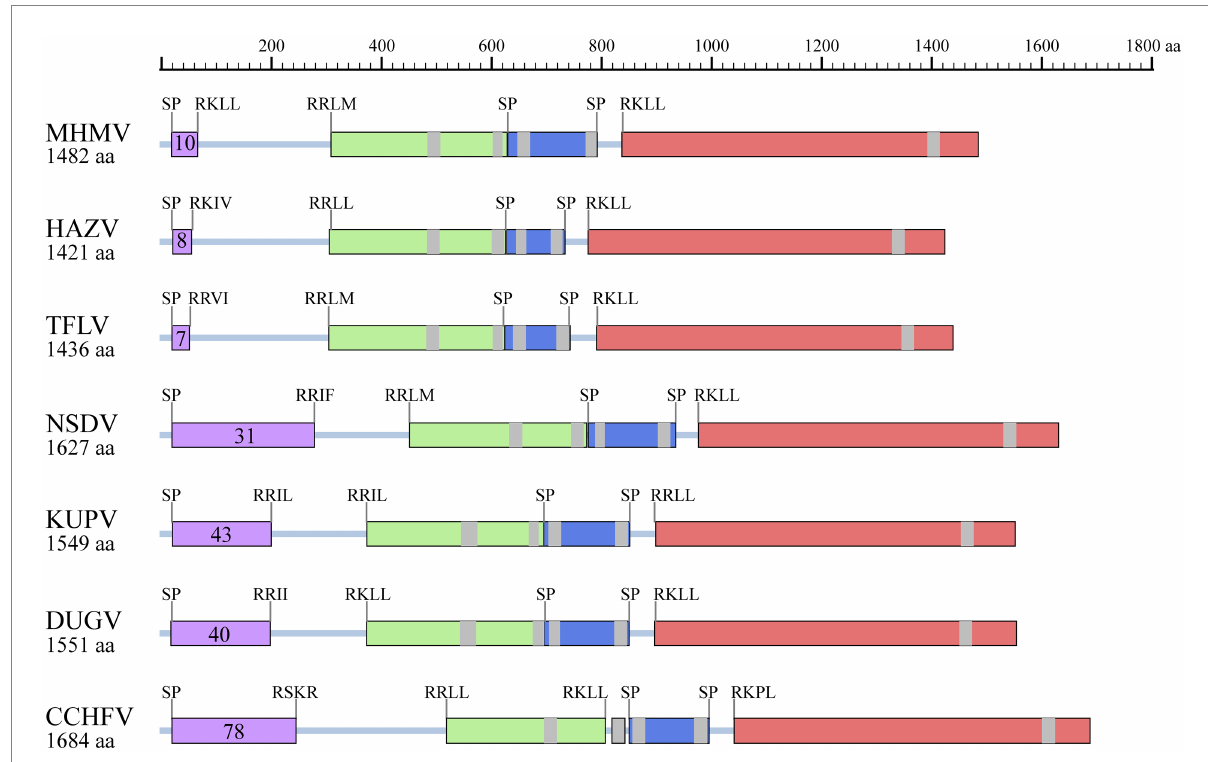
FIGURE 4 Illustration of GPC structures of the NSD genogroup viruses. Mucin-like domain (purple), Gn (light green), NSm (dark blue), and Gc (pink) are shaded correspondingly. Predicted signal peptidase (SP) cleavage sites and putative furin-like and subtilisin/kexin-isozyme-1 (SKI-I) cleavage sites are labeled. The number of predicted O -linked glycosylation sites in the mucin-like domain is also shown in the purple shaded box. The transmembrane domains are shaded with grey. The protein length is scaled. HAZV, Hazara virus; TFLV, Tofla virus; NSDV, Nairobi sheep disease virus; KUPV, Kupe virus; DUGV, Dugbe virus; CCHFV, Crimean-Congo hemorrhagic fever